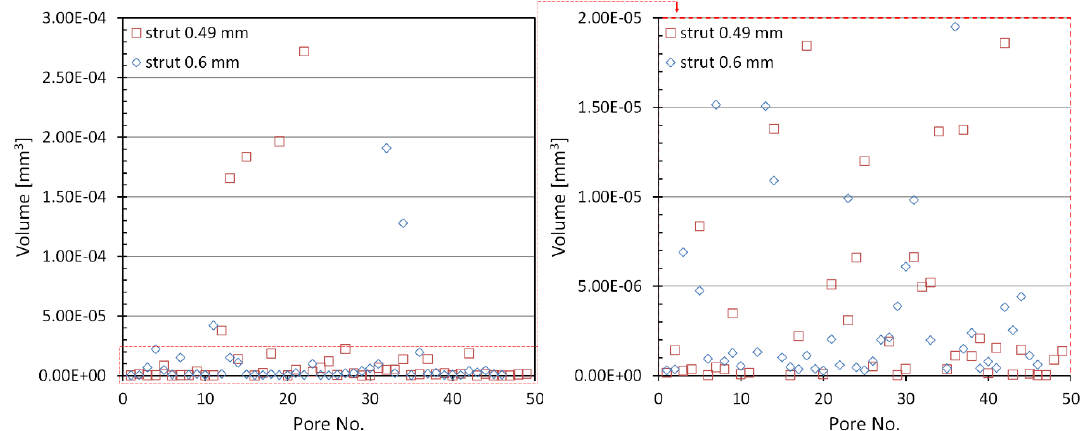
Figure 7. Volume distribution of closed micropores in the investigated struts.